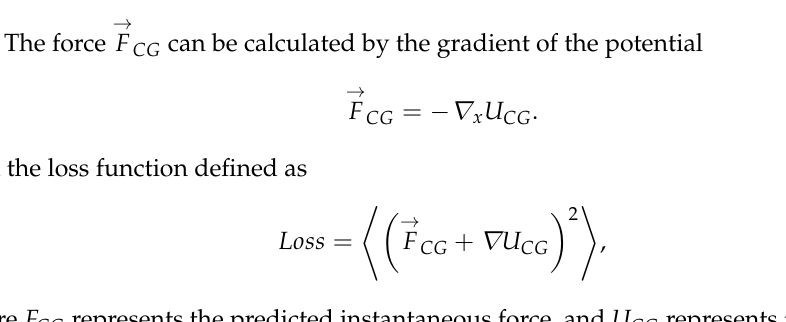
Figure 3. The proposed physics ‐ informed model architecture.